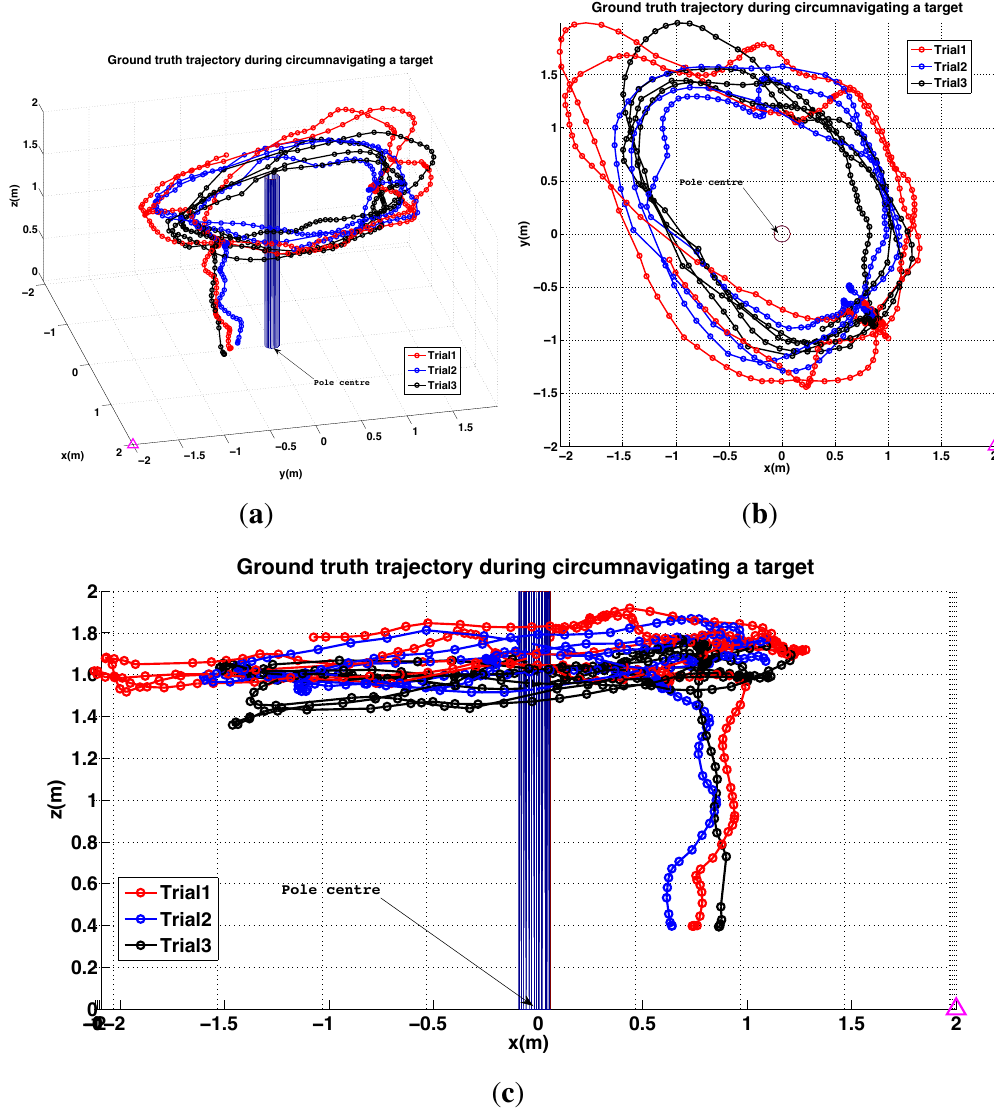
Figure 40. Experimental results for Pilot 2 during manual circumnavigation, 3D views. The magenta triangle indicates where the pilot was standing. ( a ) Perspective view; ( b ) Top view; ( c ) Side